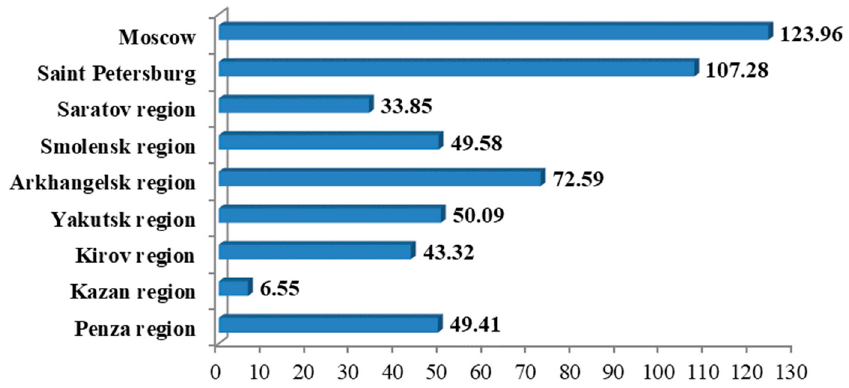
Figure 3. Total SARS-CoV-2 incidence per 1000 people at the time of the study. The highest lethality rates, defined as the ratio of deaths occurring because of SARS- CoV-2 to the total number of people affected by the disease during the pandemic period, were recorded in Saint Petersburg, Penza, and Smolensk regions ( p < 0.05). The minimum value of this indicator was observed in the Kirov region ( p < 0.05) (Figure